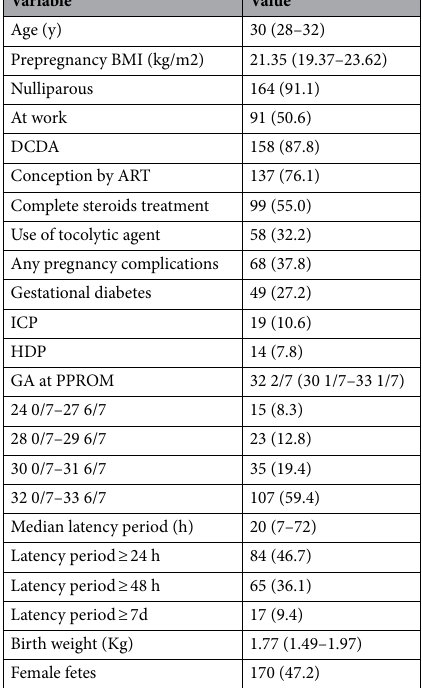
Table 1. Demographic and clinical characteristics of twin pregnancies with PPROM. Data are median (IQR, Q1-Q3) or N (%). BMI body mass index, DCDA dichorionic diamniotic, ART assisted reproductive technology, ICP intrahepatic cholestasis of pregnancy, HDP hypertensive disorder of pregnancy, GA gestational age, PPROM pretem premature rupture of membranes.